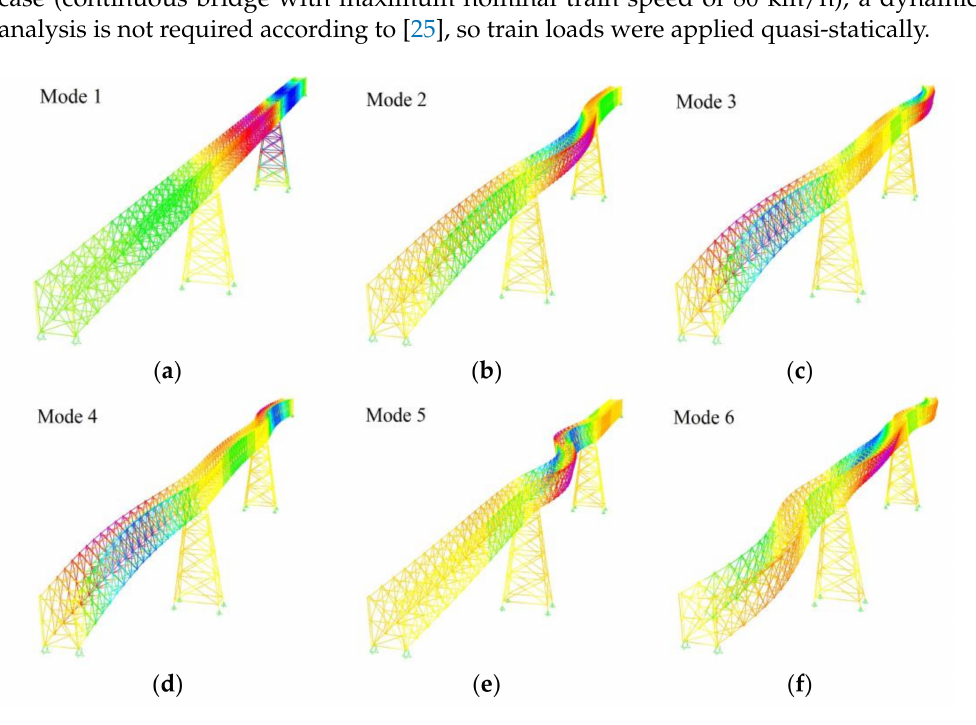
Figure 5. First six mode shapes and their corresponding natural frequencies of the bridge. ( a ) Mode 1, f 1 = 1.53 Hz. ( b ) Mode 2, f 2 = 1.58 Hz. ( c ) Mode 3, f 3 = 2.13 Hz. ( d ) Mode 4, f 4 = 2.25 Hz. ( e ) Mode 5, f 5 = 3.87 Hz. ( f ) Mode 6, f 6 = 4.91